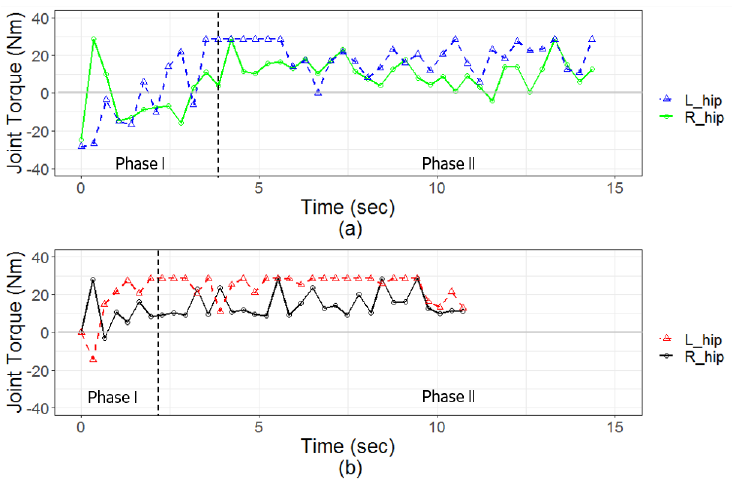
Figure 14. Joint torque measured from the hip joint using the correct ( a ) and incorrect ( b ) methods of standing